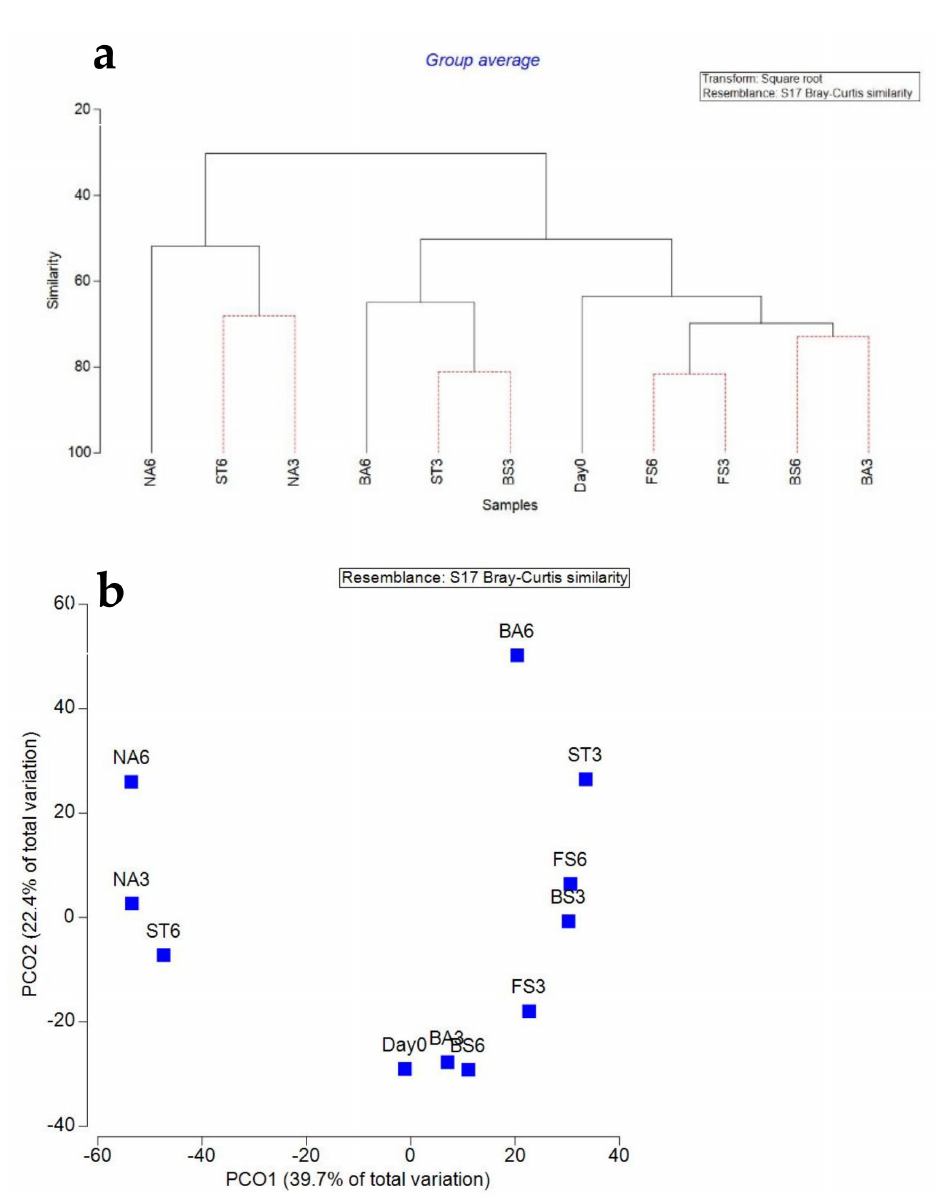
Figure 4. ( a ) UPGMA clustering analysis and ( b ) principal coordinate analysis (PCoA) constructs. NA: Natural attenuation; FS: Fusarium solani ; BS: Biostimulation; BA: Bacilli, ST: Streptomyces ; 3, 6: